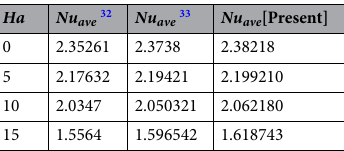
Table 2. Comparison of current results and published work on traditional fluids having common parameters .